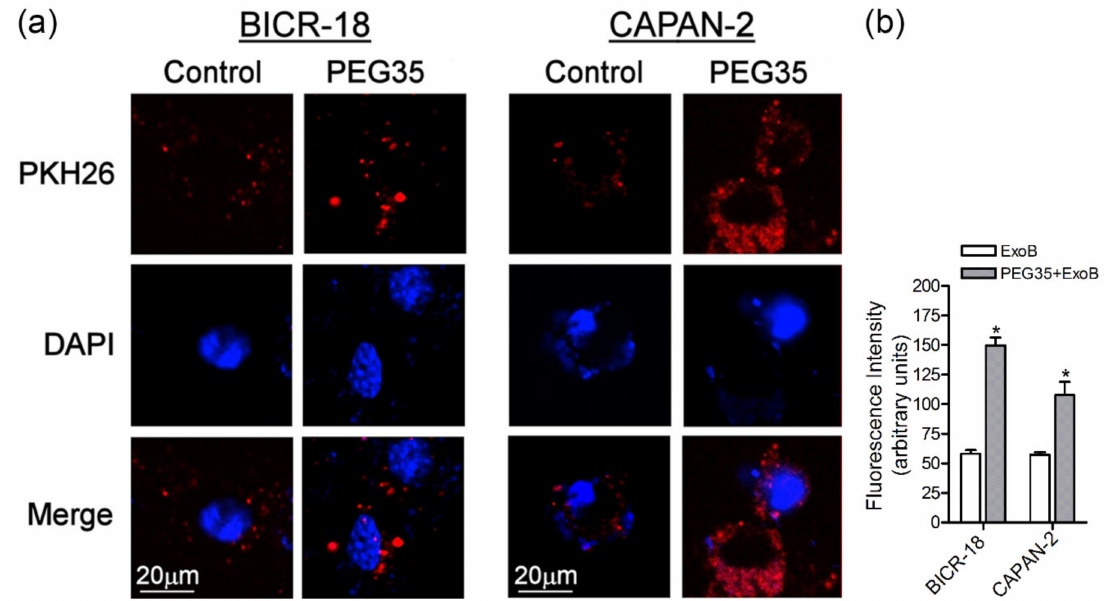
Figure 3. PEG35 enhanced the uptake of exosomes by epithelial cells. ( a ) Representative images showing internalized ExoB by epithelial BICR-18 and CAPAN-2 cells under treatment with 4% PEG35: untreated and PEG35-treated cells were fixed and then were imaged with confocal microscopy (scale bar, 20 µ m; blue, DAPI stained nuclei; and red, PKH26 stained exosomes). ( b ) Fluorescence intensity analysis of the PKH26-labelled exosomes: the values shown represent the mean ± SEM. * p < 0.05 versus ExoB. Data is representative of several repeated experiments. ExoB, exosomes from BICR-18 cells; PEG35, 35-kDa polyethylene